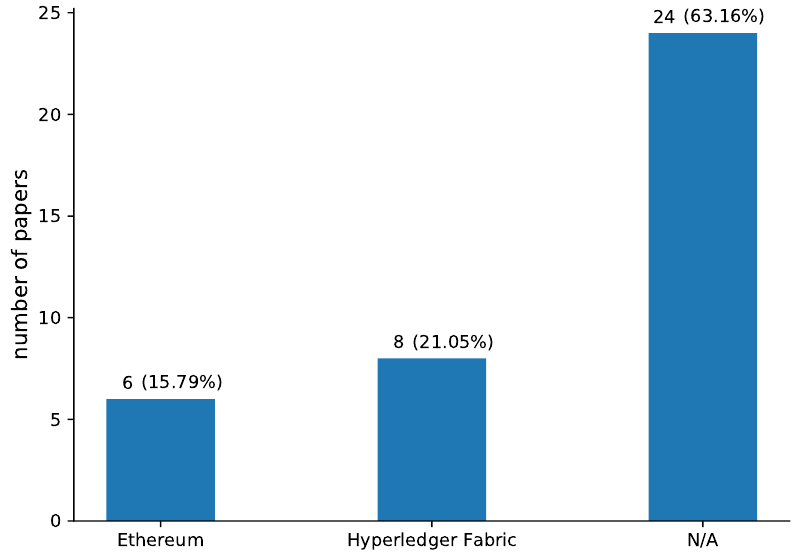
Figure 8. Blockchain frameworks (RQ4) presented in the papers included in our